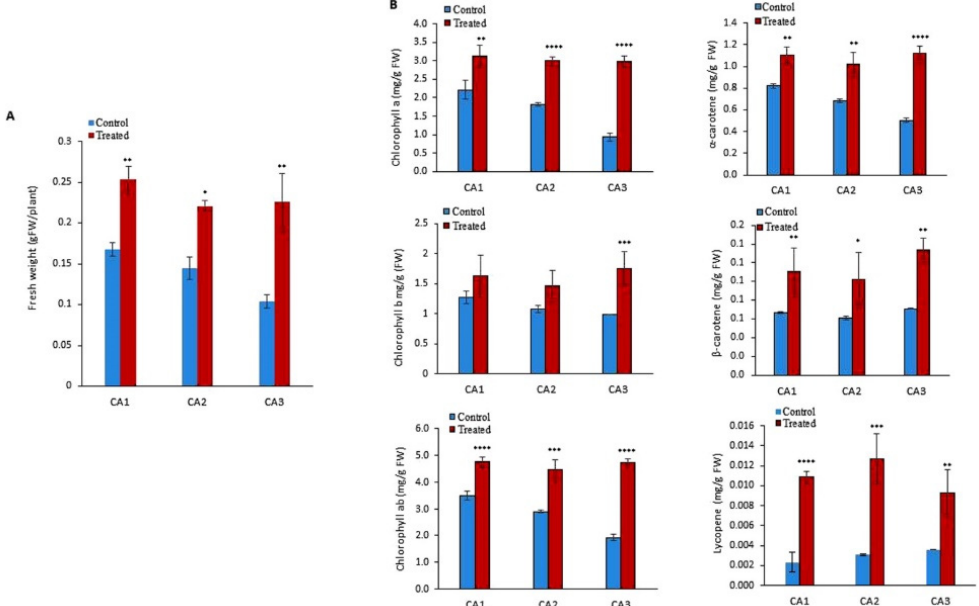
Figure 1. Impacts of molybdenum (Mo) seed priming on different Canavalia species. ( A ): Total biomass (gFW). ( B ): Chlorophyll a, b, and ab content, α -carotene content, β -carotene content, and lycopene content were measured and expressed as mg/gFW. Control; without treatment, Treated; Mo treatment. CA1; Canavalia ensiformis var. gladiata , CA2; Canavalia ensiformis var. truncata Ricker , CA3; Canavalia gladiata var. alba Hisauc . α -carotene, or β -carotene, Beta-carotene. The bars above mean indicate ± standard deviation (S.D) of three independent replicates ( n = 3). Asterisks (*) show the level of significance * p < 0.05, ** p < 0.01, *** p < 0.001, **** p <